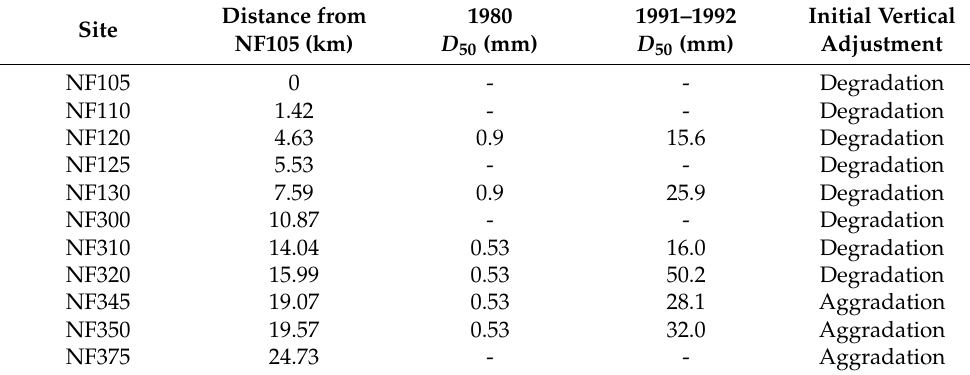
Figure 4. Sediment flux in NFTR. ( a ) Measured sediment flux [10]; ( b ) predicted cumulative sediment yield (dashed lines refer to 1999 and 2035) [15]. Table 1. Particle size of sampled bed material [10].